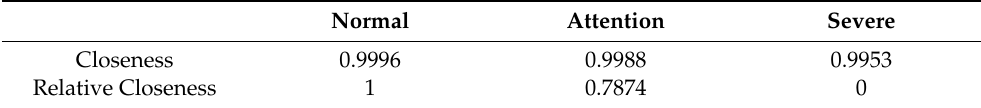
Table 10. Closeness of protection system at moment 3 to each state level. Normal Attention Severe Closeness